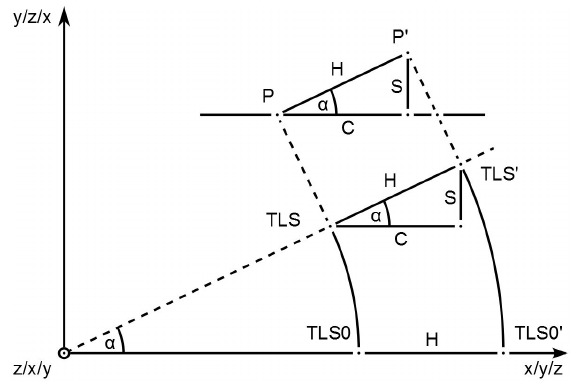
Figure 3. Impact of a specifically biased lever arm; when the lever arm is incorrectly determined by the amount of H and the system is rotated by the angle, α , the wrong lever arm can result in an error of C and S , causing the actual measured point, P , to be at the wrong point, P (cid:48)